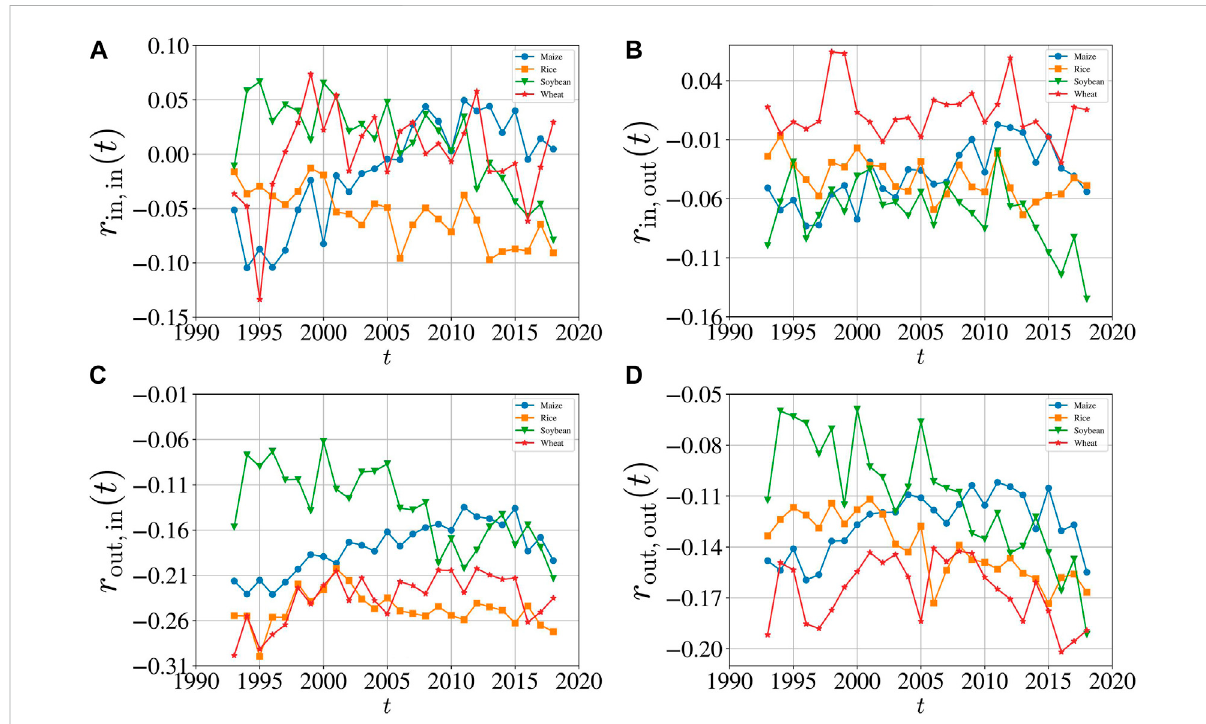
FIGURE 7 Evolution of degree assortative coef fi cients of the four iCTNs from 1993 to 2018. (A) The degree assortative coef fi cient r in,in ( t ) between the in- degree of exporting economies and the in-degree of importing economies. (B) The degree assortative coef fi cient r in,out ( t ) between the in-degree of exporting economies and the out-degree of importing economies. (C) The degree assortative coef fi cient r out,in ( t ) between the out-degree of exporting economies and the in-degree of importing economies. (D) The degree assortative coef fi cient r out,out ( t ) between the out-degree of exporting economies and the out-degree of importing